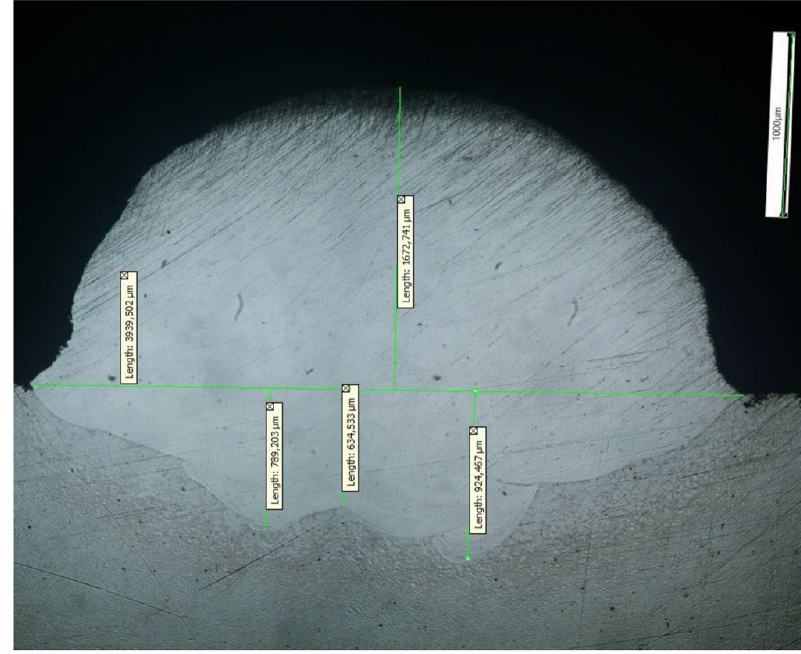
Figure 6. Macrostructure of the bead obtained by mode No.